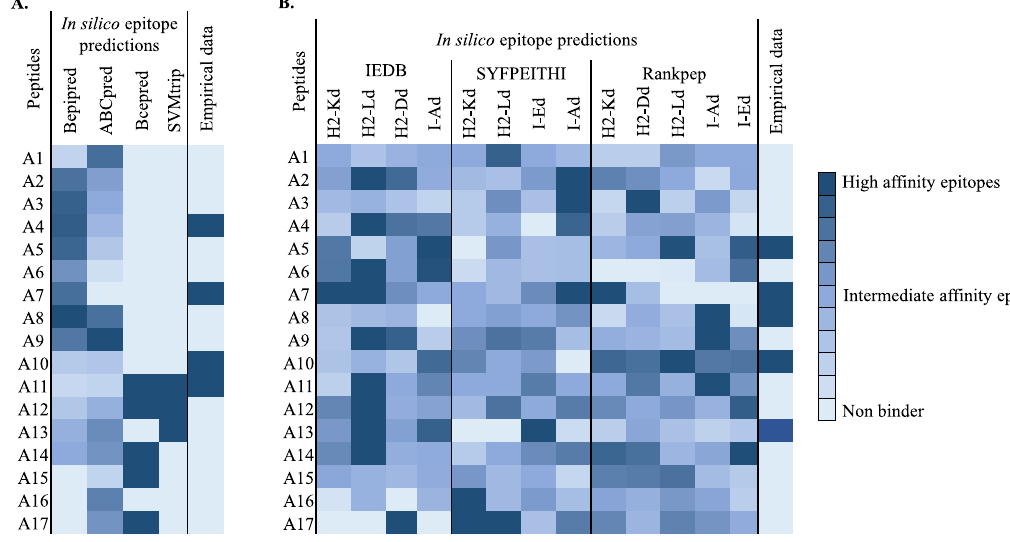
Figure 5. Heat maps depicting the predicted binding affinities of the AdLP-D1 B and T-cell epitopes for peptides A1–A17. ( A ) B-cell epitopes. Predictions were made using BcePred 31 1.0 server, ABCpred 18 , SVMtrip 20 and BepiPred 32 . ( B ) T-cell epitopes. Predictions were made based on their binding affinities towards MHC class I and MHC class II alleles using IEDB 15 , SYFPEITHI 14 and Rankpep 13 . The peptides empirically mapped as B-cell or T-cell epitopes are shown alongside the